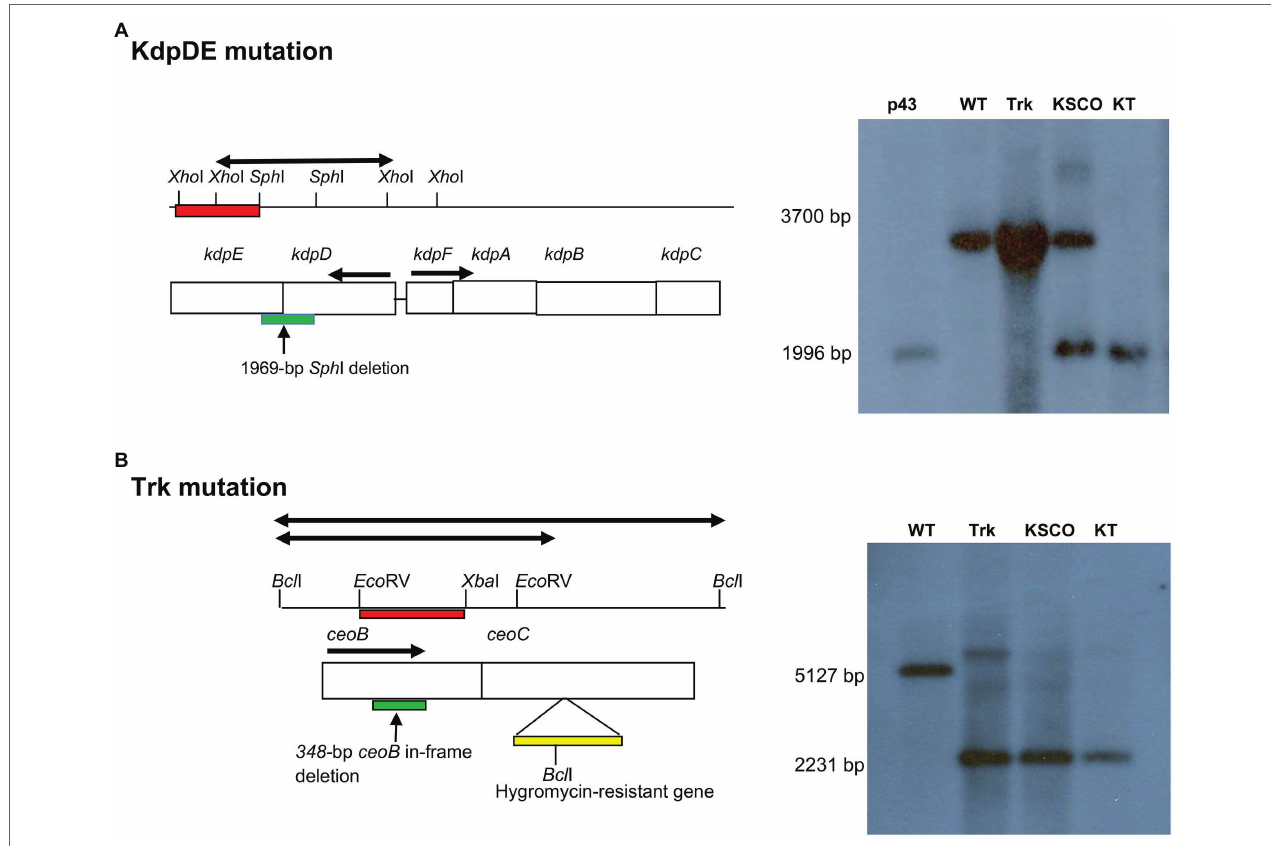
FIGURE 1 | Schematic illustrations of allelic exchange mutagenesis of the kdpDE and ceoBC mutations in the KT-double knockout strain of M. tuberculosis as shown previously for inactivation of the single Trk- and KdpDE-deletion mutant strains (Parish et al., 2003; Cholo et al., 2006). The maps were not drawn to scale. DNA samples were digested with (A) Xho I and probed with 1,010-bp kdpDE PCR-synthesized fragments (red bar) for detection of the 1996-bp Xho I- kdpDE mutated fragment (thick black arrow) and (B) Bcl I and probed with 714-bp ceoB PCR-synthesized fragment (red bar) for detection of the 2,231-bp Bcl I- ceoBC mutated fragment (thick black arrow). Deletions in kdpDE and ceoB genes are shown by green bars, while insertion of the hyg gene in ceoC gene is shown by yellow bar. p43, pSOUP43; WT, wild type; Trk, Trk-deletion; KSCO, kdpDE single crossover; KT, KT-double knockout.